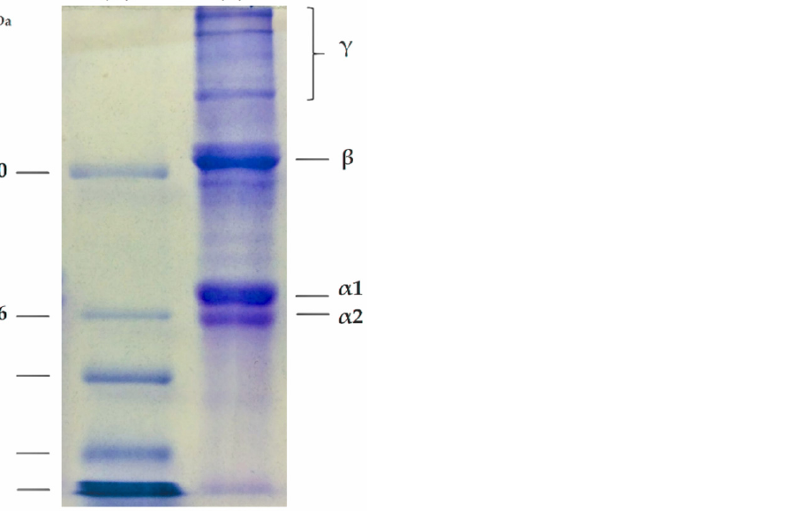
Figure 1. SDS-PAGE of ( A ) a protein marker; and ( B ) the extracted collagen from Tilapia skin. Collagen extracted from tilapia fish skin mainly contained two identical α 1 chains, one α 2 chain and other less intense bands, β and γ bands, which can be associated with non-dissociated, respectively, dimers and trimers from α -helix and other crosslinked constituents [20]. The molecular weight of α chains extracted from fish skin was about 130–150 KDa, which can be originated from minor differences in amino acid composition influencing the molecular weight, being in accordance with the literature [21]. In addition, the α 1/ α 2 ratio was measured with optical densitometry, and the value was 2.02, which indicates a trimer (( α 1) 2 α 2) that confirms a type I